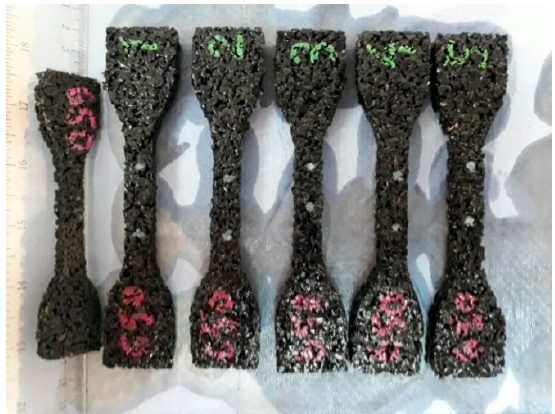
Figure 17. Change of length for sample SBR 650 after 7 days in oil.